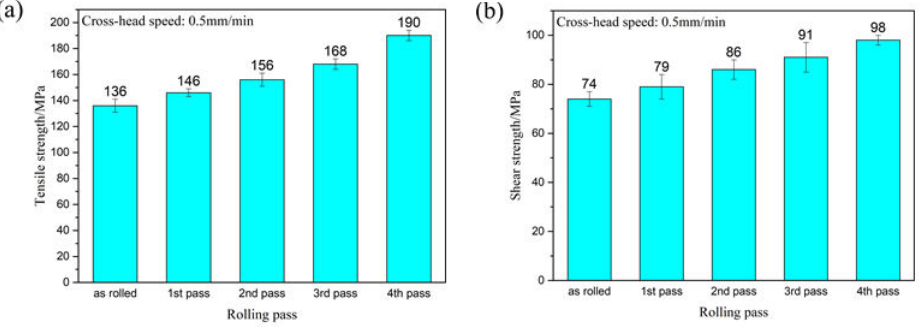
Figure 10. Tensile strength ( a ) and shear strength ( b ) of Al/Mg composite plate under different rolling